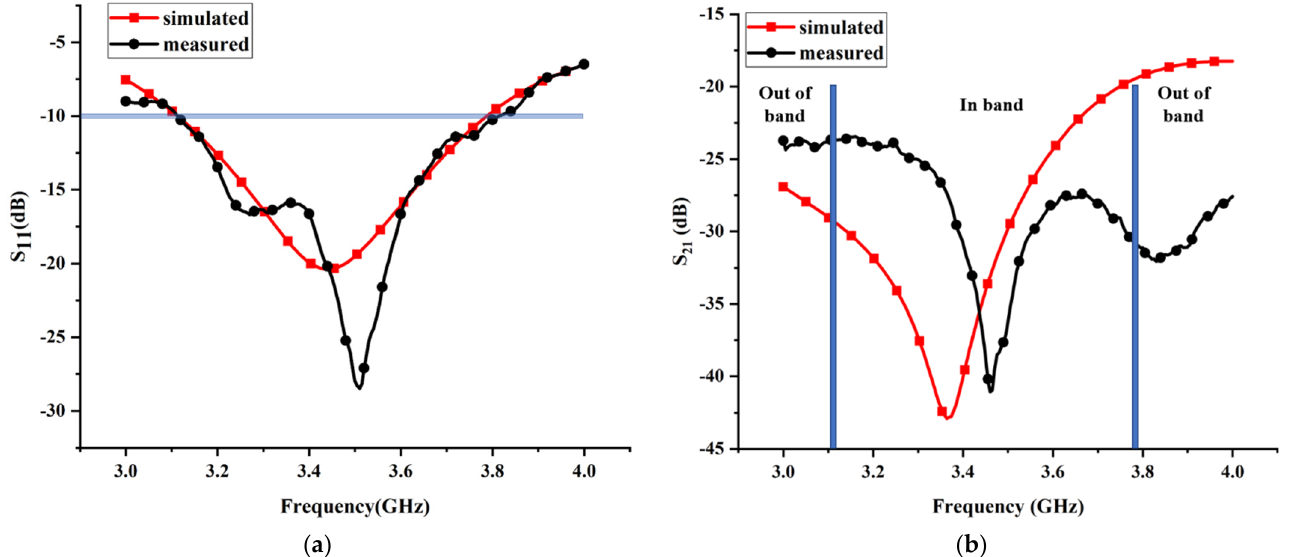
Figure 18. Measured and simulated S-parameters for the proposed MIMO antenna: ( a ) reflection coefficient; ( b ) transmission coefficient. coefficient; ( b ) transmission